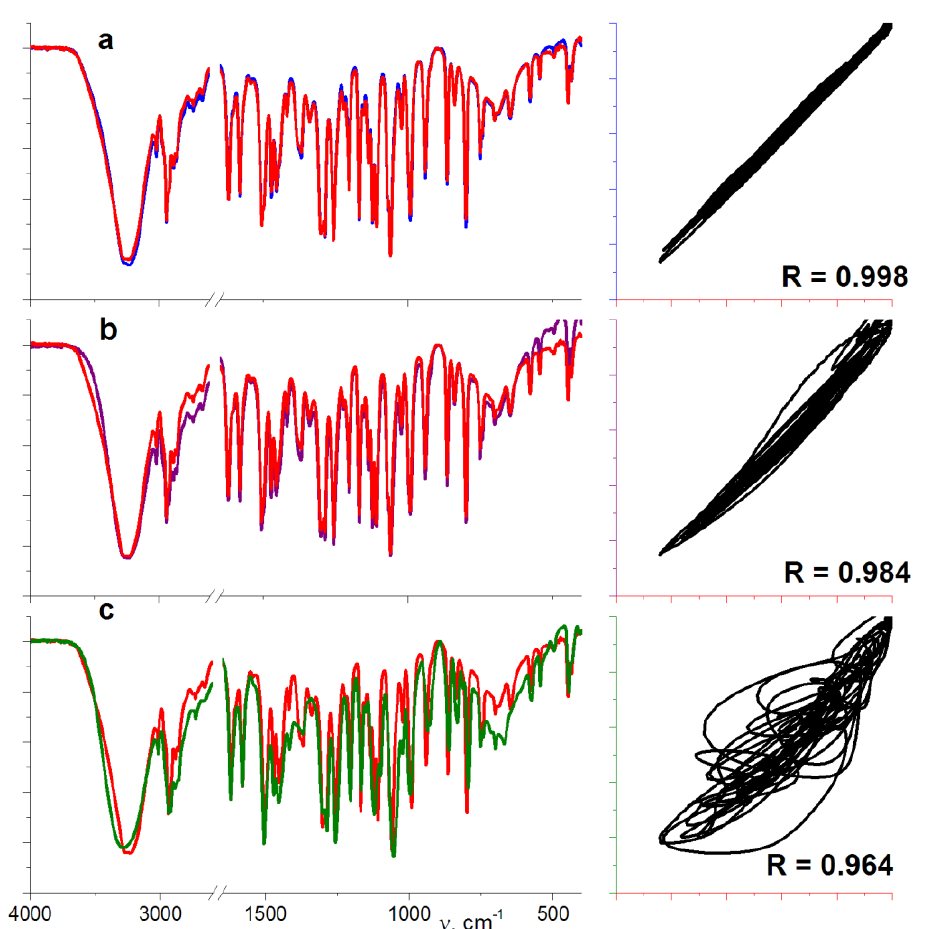
Figure 5. Comparison of the IR spectrum of conglomerate ( R + S )- 1 (red curve) with the spectra of samples ( R )- 1 ( a ), (blue curve), α - rac - 1 ( b ), (violet curve), and β - rac - 1 ( c ), (olive